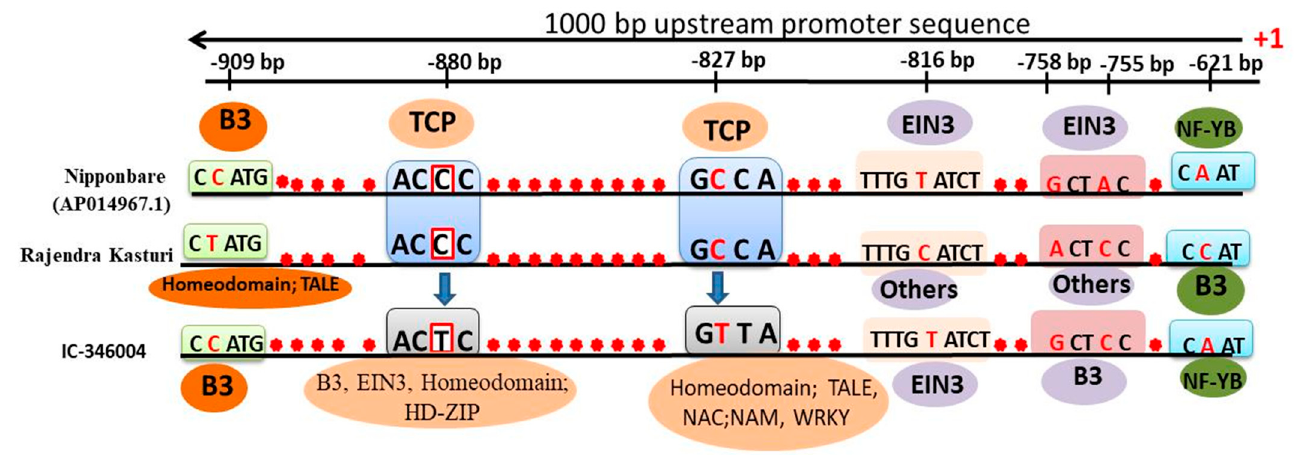
Figure 12. In silico analysis of the putative promoter regions of OsCBP60g-4 in M. oryzae resistant and susceptible rice genotypes. A 1000 bp upstream region of OsCBP60g-4 gene from each genotype, Rajendra Kasturi (indica rice genotype susceptible to M. oryzae ) and IC-346004 (indica rice accession resistant to M. oryzae ), was amplified and sequenced. Multiple sequence alignment of reference sequences (Nipponbare; AP014967.1) available in NCBI was performed to identify SNPs. The SNPs associated with TF binding sites are highlighted in different colours and shown in circles. The red colour stars (*) indicate conserved residues in both sequences.